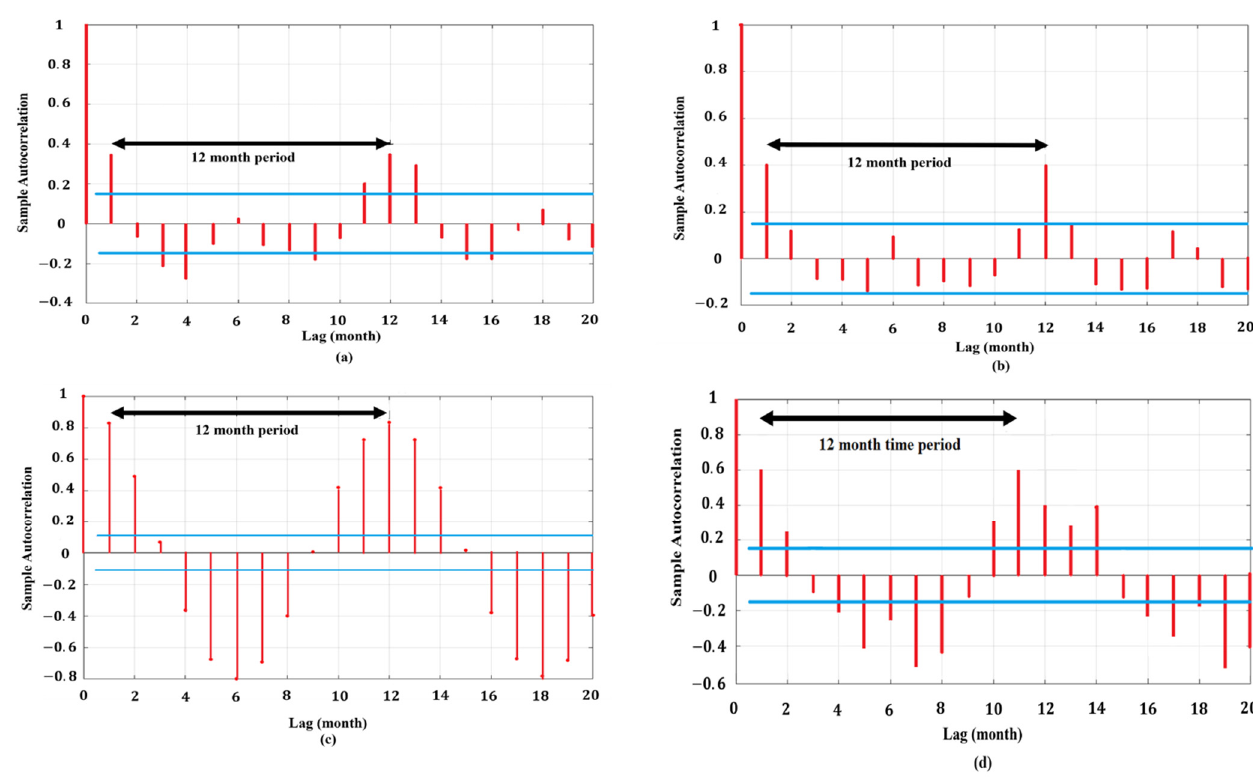
Figure 4. The time series’ correlograms of ( a ) monthly precipitation in AC, ( b ) monthly precipitation in NC, ( c ) monthly temperature in NC, ( d ) monthly temperature in AC. Table 2. Mann–Kendall Z-values and correlation coefficients of monthly time